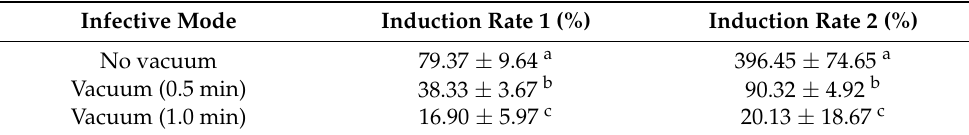
Table 2. Effect of infective mode on induction.